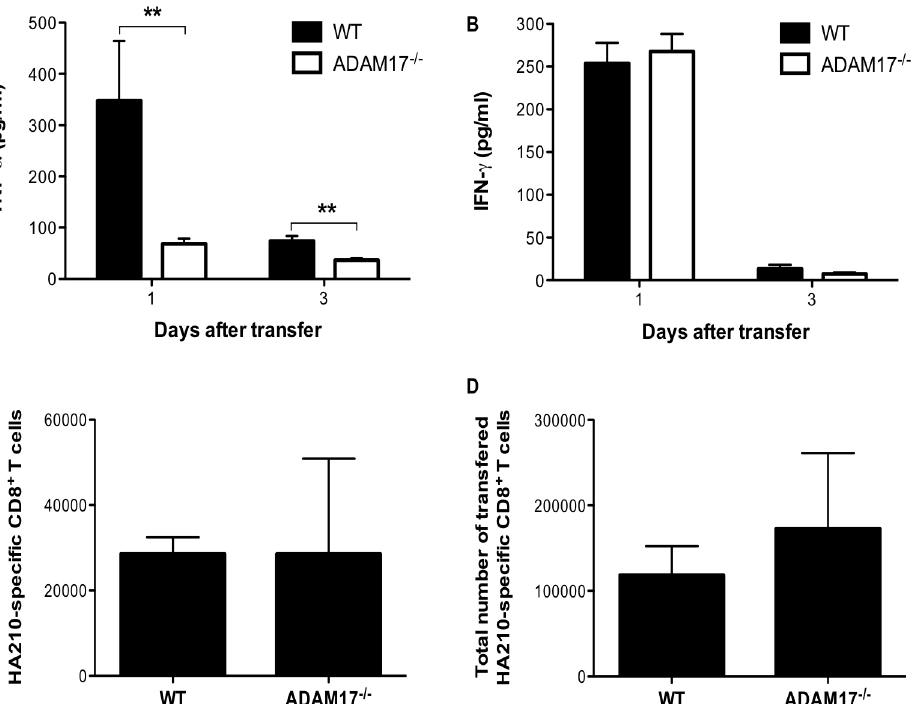
Figure 6. CD8 + T-cell expression of ADAM17 is required for TNF- a processing following antigen recognition invivo . SPC-HA transgenic mice received 10 7 WT or ADAM17 2 / 2 HA-specific CD8 + T cells via tail vein injection. ELISA was used to assess (A) TNF- a and (B) IFN- c expression in cell-free BAL fluid. Alternatively, HA-specific CD8 + T cells were labeled with CFSE prior to transfer. Twenty-four hours after transfer, cells were recovered from (C) BAL and (D) lung homogenates and assessed by flow cytometric analysis to determine the total number of transferred HA-specific CD8 + T cells present. Data represent mean 6 standard deviation. Data are representative of two or more independent experiments with 4 mice per group. ** P ,